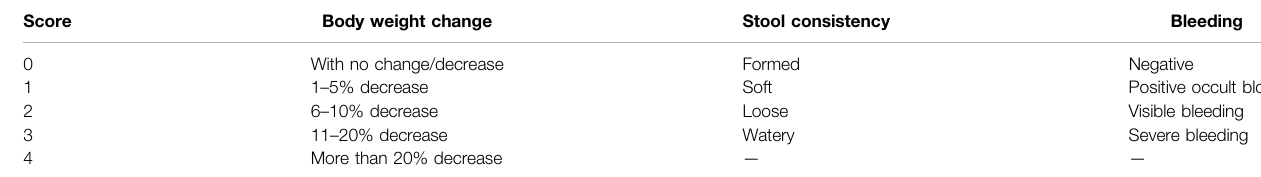
TABLE 1 | The standard of DAI score.